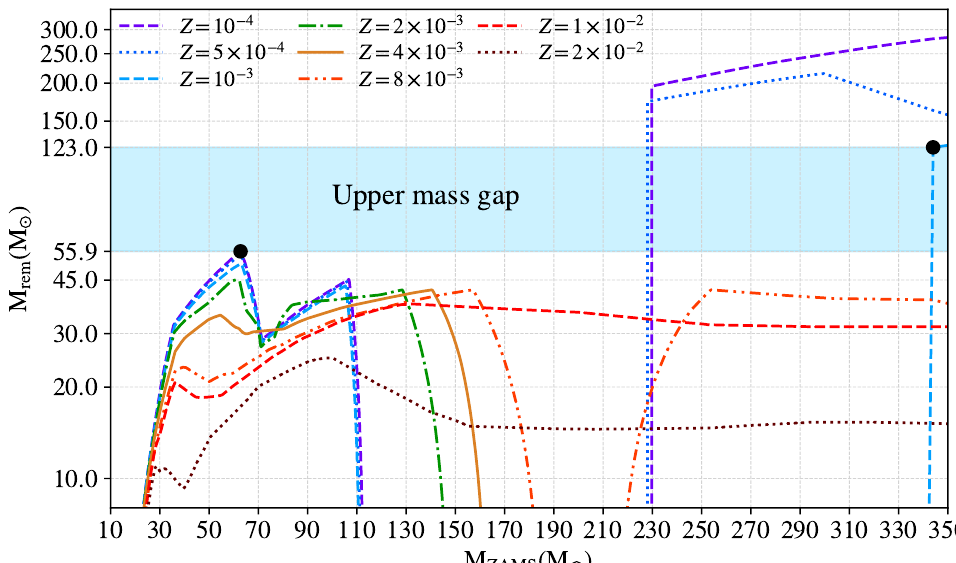
Figure 4. Mass of the BH as a function of the initial mass of its progenitor star, for different values of metallicity Z ∈ [ 10 − 4 ;2 × 10 − 2 ] . The shaded cyan area shows the location of the upper mass gap. The two black points set the lower edge ( ∼ 55.9M (cid:12) ) and the upper edge ( ∼ 123M (cid:12) ) of the gap. The plot has been adapted from Spera and Mapelli [97] and it has been obtained through the SEVN code coupled with look-up tables from PARSEC [98] and the delayed SN explosion model